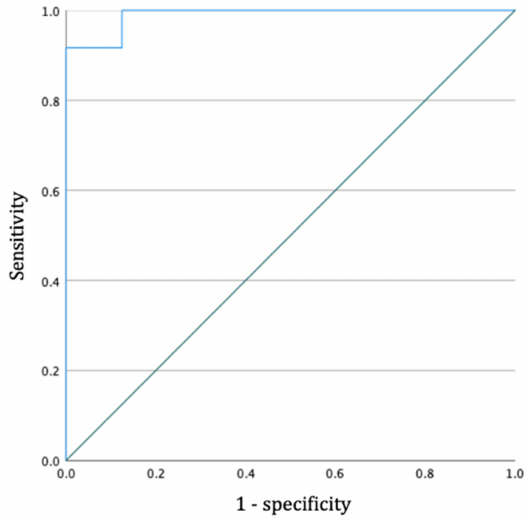
Figure 3. Receiver operating characteristic (ROC) curve for the 16-degree cut-off value of the anterior fat pad sign ( α